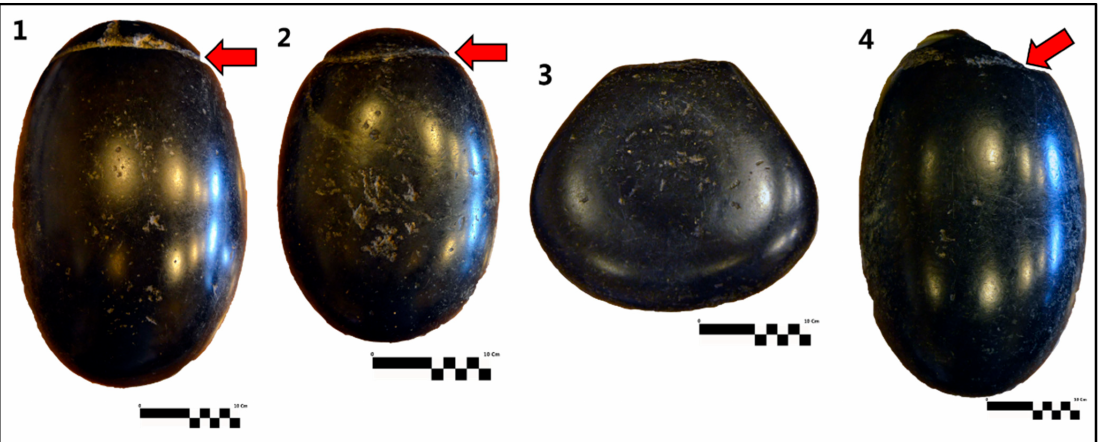
methods and rationale adopted in the present study.